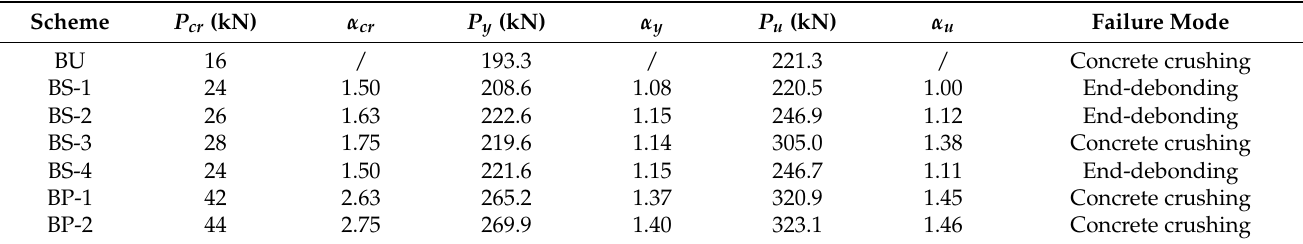
Table 3. Main test results of the specimens.